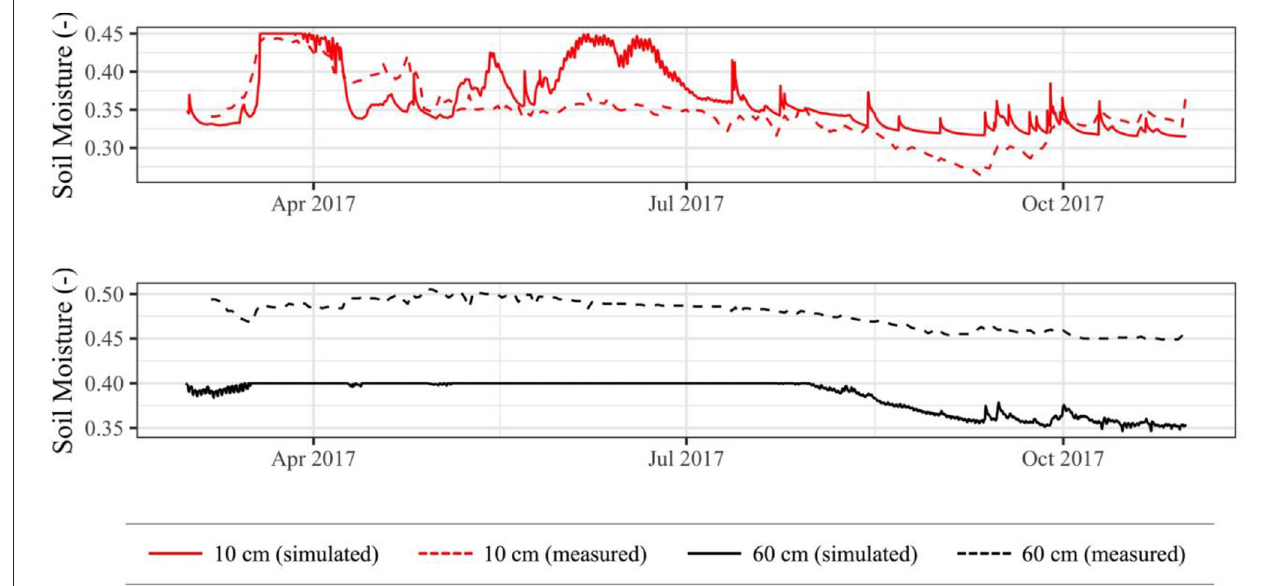
FIGURE 7 | Simulated soil moisture contents compared to in situ soil moisture contents across 2017 simulation period.